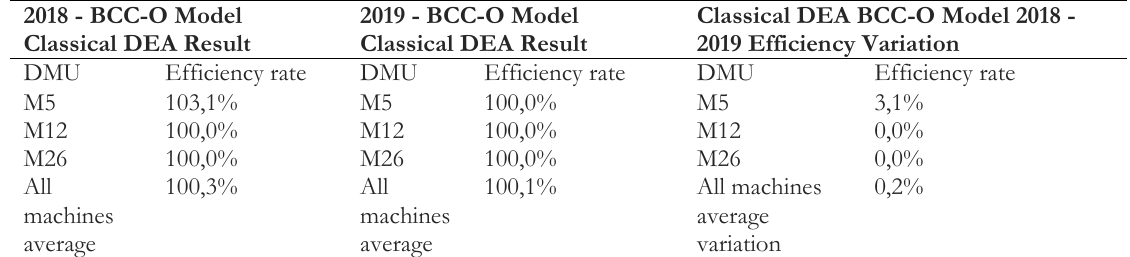
Table 5. BCC – output-oriented classical DEA results and efficiency variations.